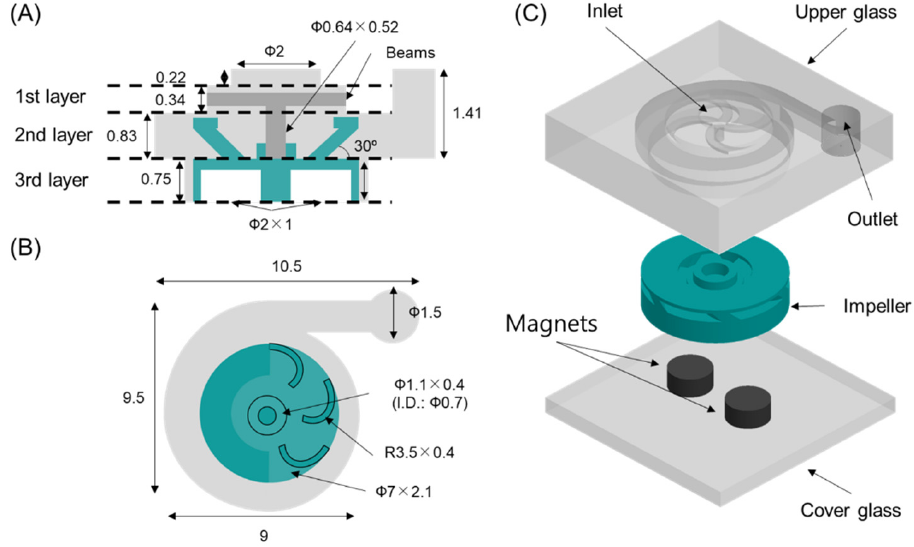
Figure 1. Schematics of a glass micropump. ( A ) side view ( B ) top view ( C ) 3D assembly (scale: